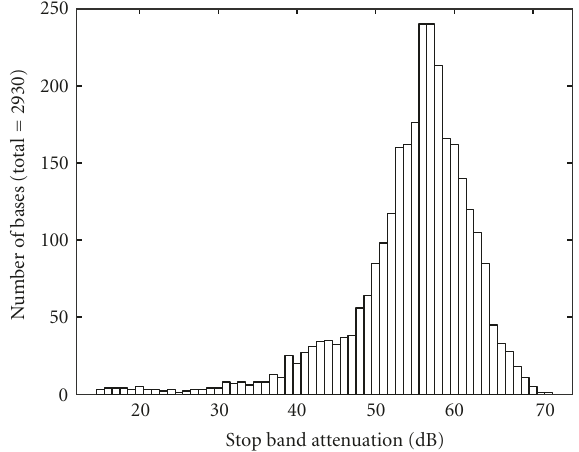
Figure 7: Histogram of stop band attenuation for bases 0.7071 to